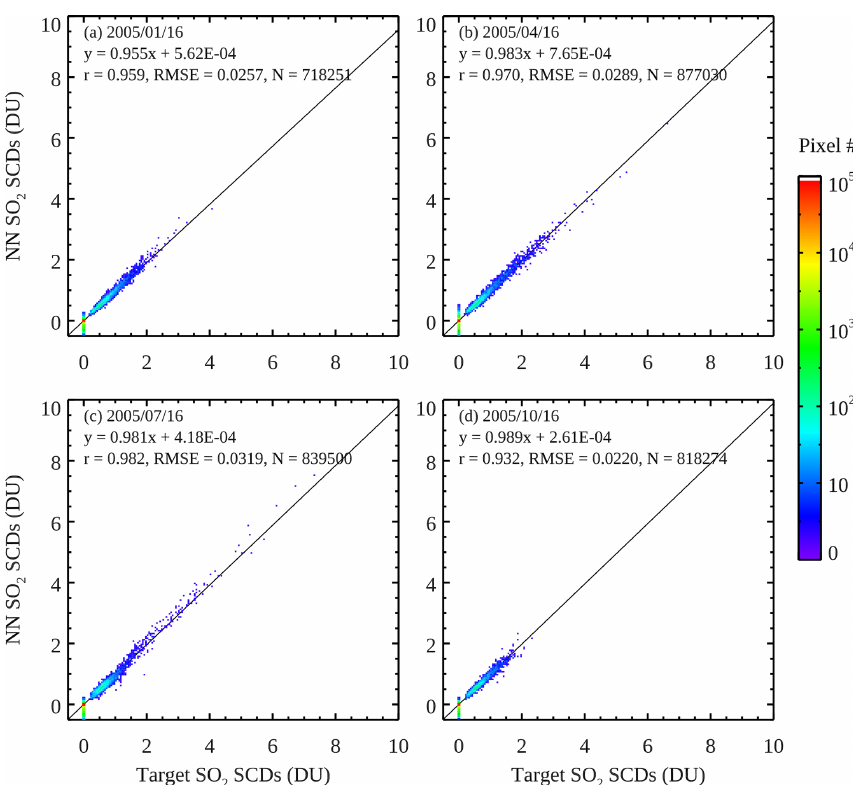
Figure 3. Scatter plots between the NN-analyzed SO 2 SCDs and the target SO 2 SCDs for clean and polluted OMI pixels from the 16th day of (a) March, (b) April, (c) July, and (d) October 2005. Only pixels not used in the training of the neural networks are shown. Colors represent the number of data points within each 0.1DU (in NN SCDs) by 0.1DU (in target SCDs) bin. The solid line in each panel represents the best fit through the data from the simple linear regression analysis between NN and target SCDs. The slope and intercept from the regression are given in each panel, along with the correlation coefficient ( r ), root mean square error (RMSE), and number of pixels ( N ).